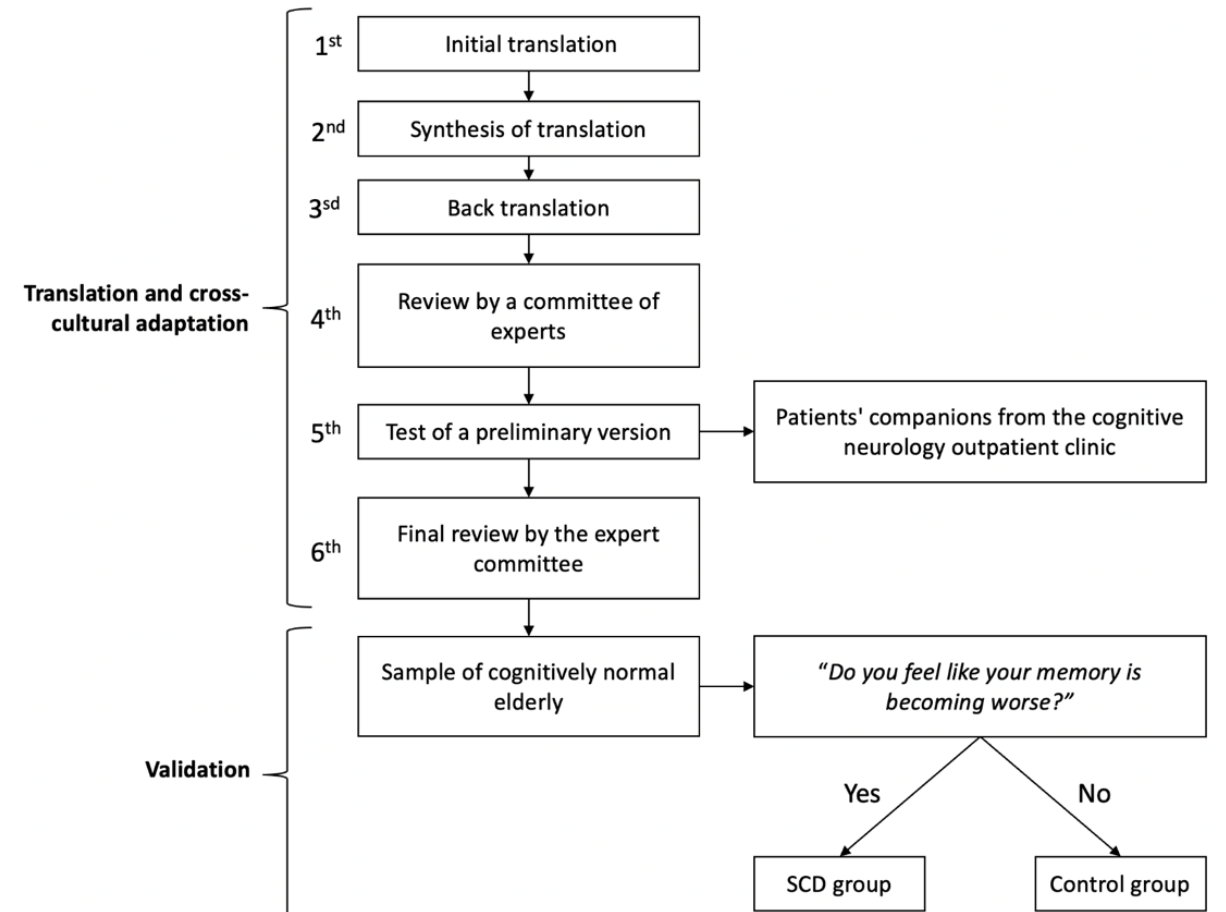
Figure 1. Study design of translation, cross-cultural adaptation, and validity of the Brazilian version of the Cognitive Function Instrument. Preliminary version was applied in a sample of cognitively normal adults recruited among the patients’ companions from the cognitive neurology outpatient clinic of the Hospital das Clínicas of the Medical School of the University of São Paulo. All participants were asked to comment on the instrument, whether they understood each question, what their doubts were, and whether they had any suggestions. After the final Brazilian version, the Cognitive Function Instrument was applied to a sample of cognitively normal elderly to validate the instrument. They were divided into two groups: with subjective cognitive decline (SCD group) and without decline (control group). The participants were recruited from different centers in the city of São Paulo,